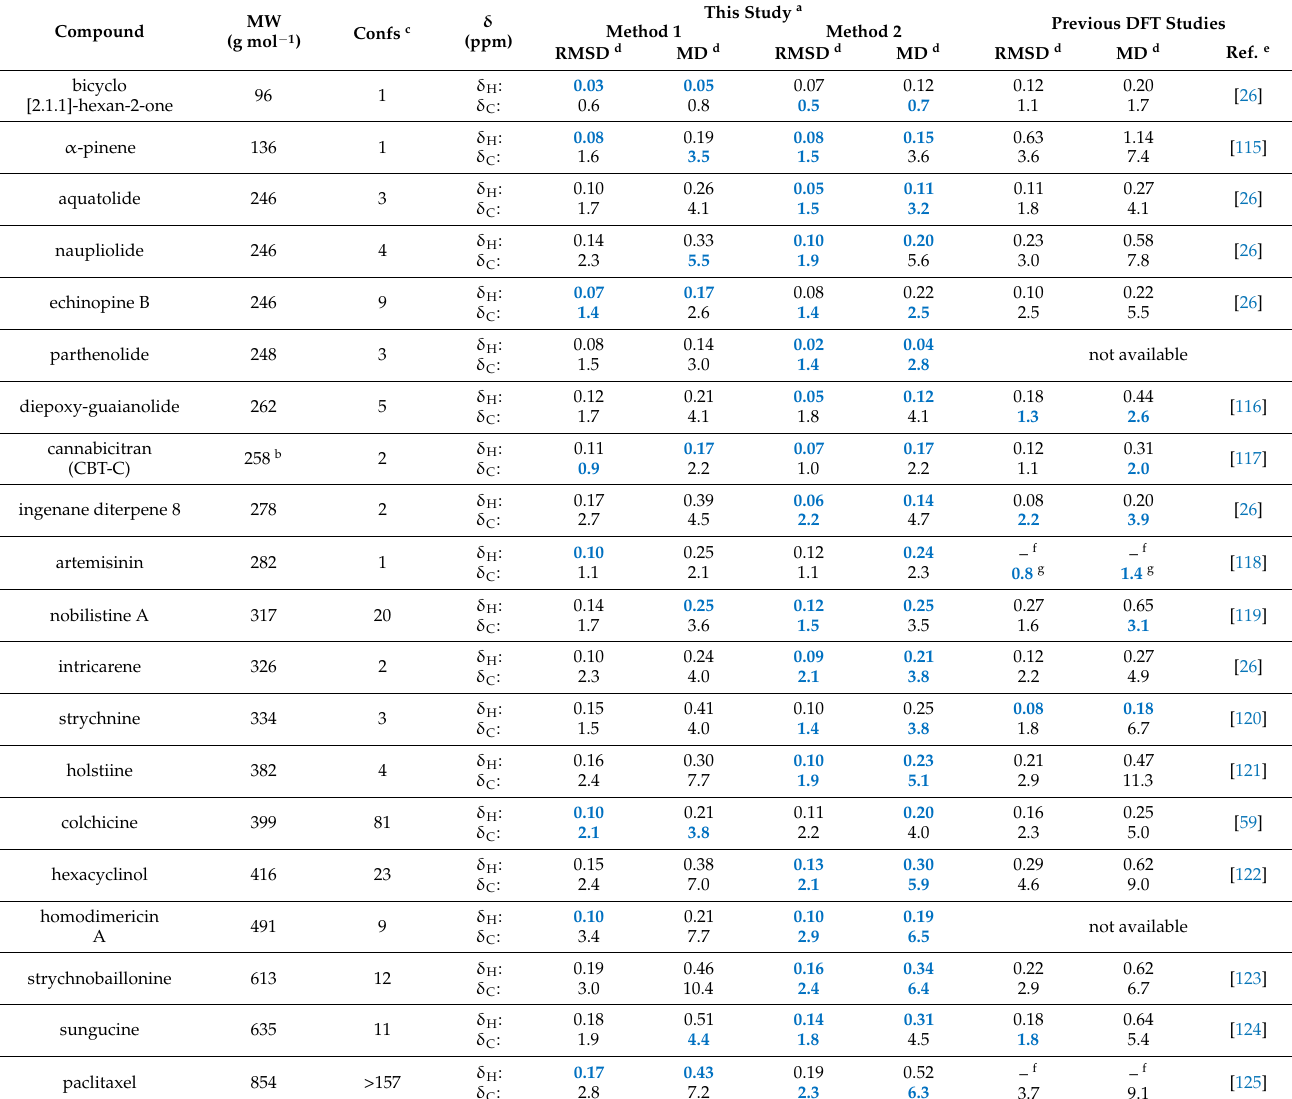
Table 8. DFT method performances for chemical shift predictions of probe